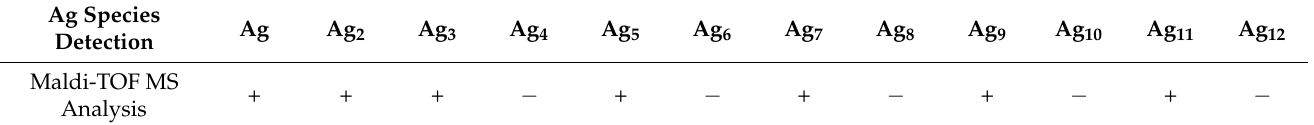
Table 1. Detectable (+) and not detectable ( − ) Ag species by MALDI-TOF mass spectrometry. Ag Species Detection Maldi-TOF MS